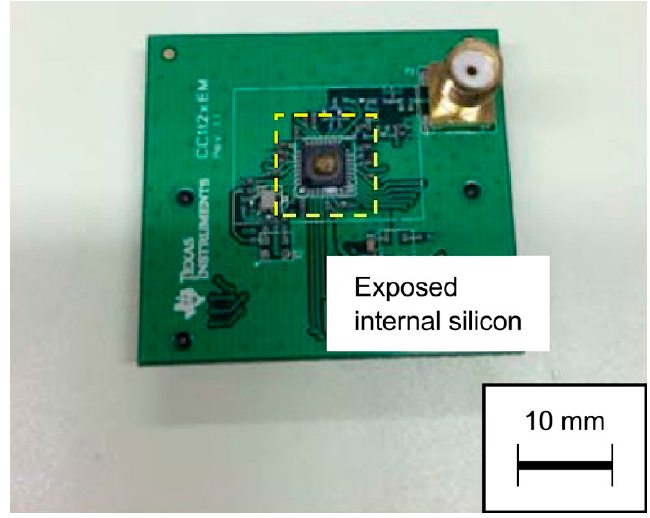
Figure 6. Wireless communication module with exposed IC internal board section.